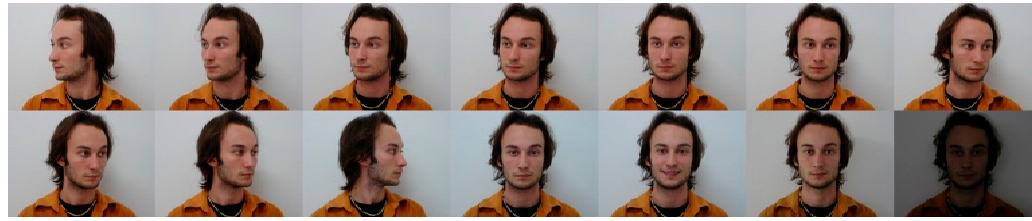
Figure 2. Various face poses for a single person from The FEI (Brazilian) Face Database.